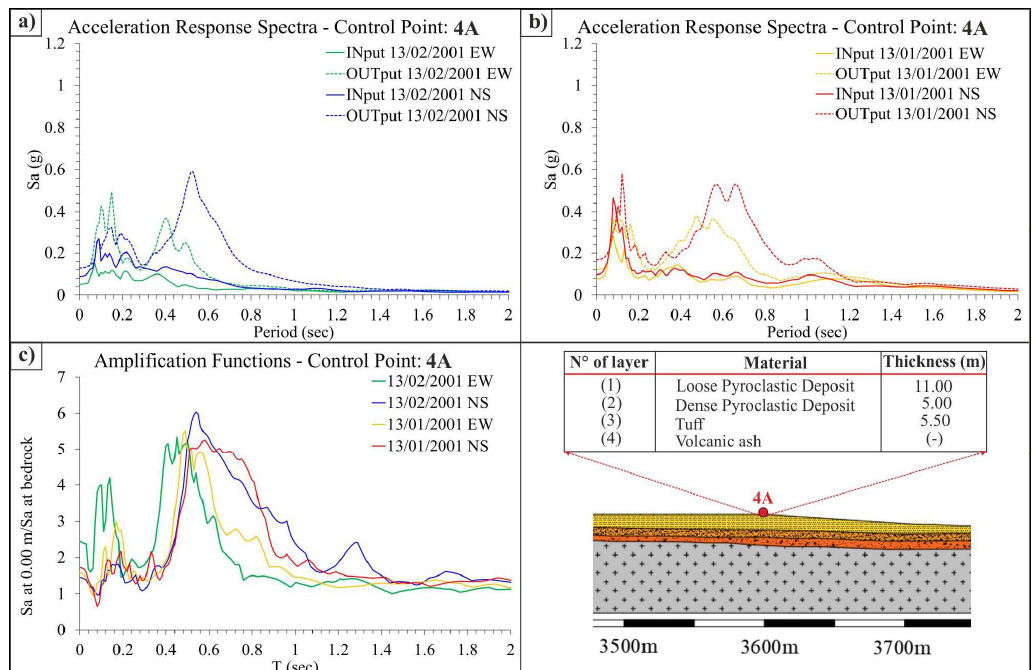
Figure 16. Section AA′: numerical control point 4A spectral responses obtained by 2D numerical analyses using LSR2D software. ( a ) Comparison among the SA of the two components of the 13 February 2001 earthquake. ( b ) Comparison among SA of the two components of the 13 January 2001 earthquake. ( c ) Amplification functions related to the four input motions.